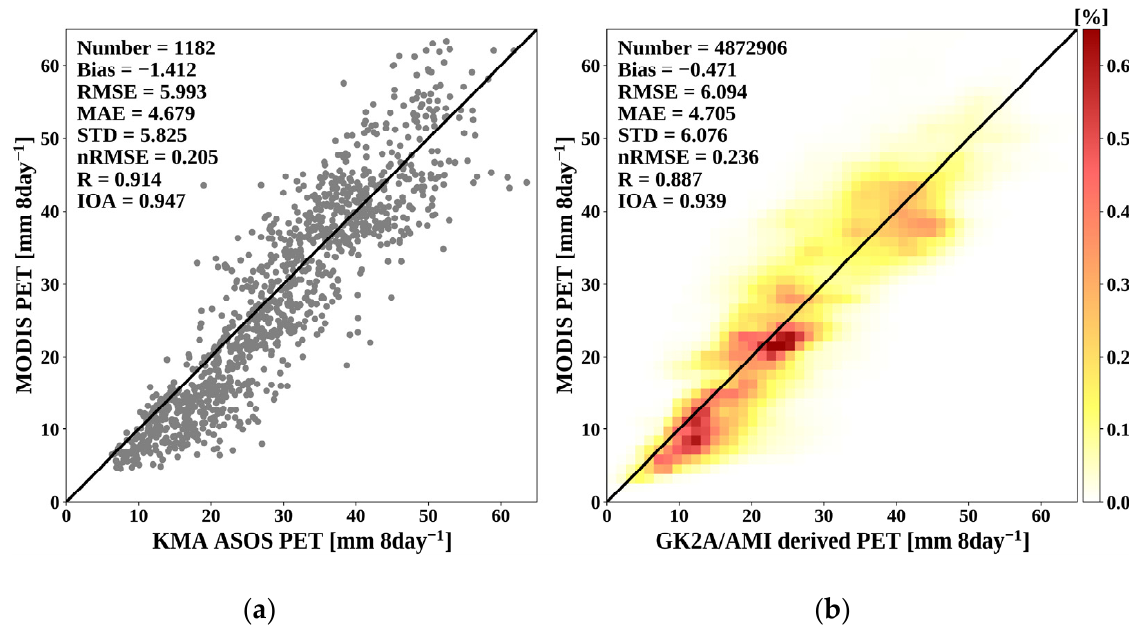
Figure 10. Validation of Terra/MODIS PET data for the period 27 July 2020 to 27 July 2021, relative to PET from ( a ) ASOS stations operated by KMA, and ( b ) the GK2A/AMI satellite.